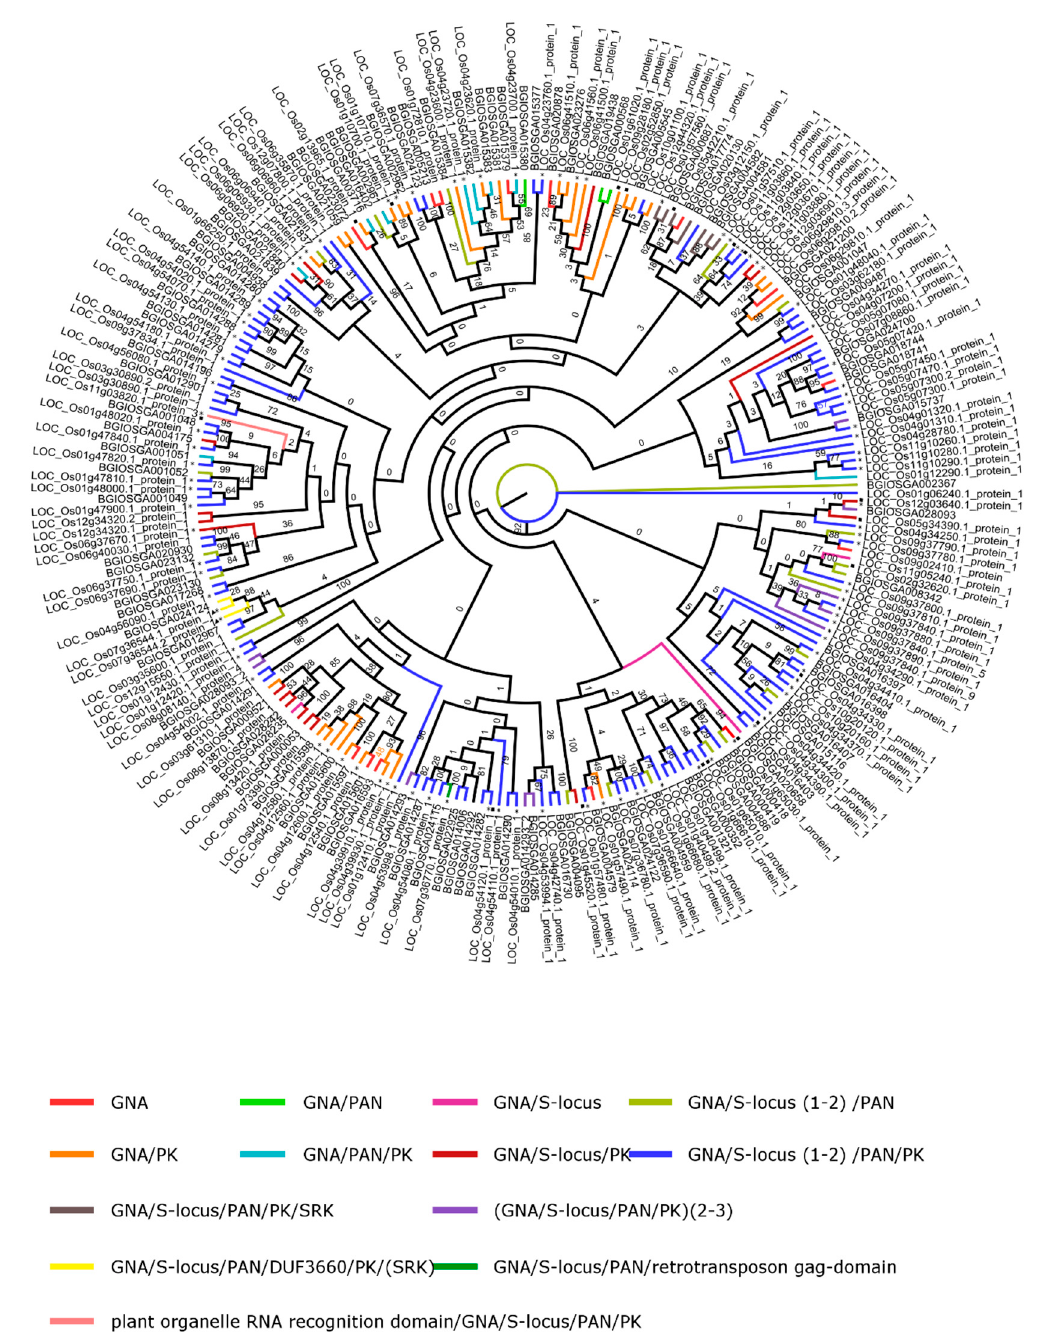
Figure 4. Phylogenetic tree of the GNA lectin family. Asterisks designate a tandem duplication event. Triangles refer to a single lectin domain in a multiple domain structure. Squares designate a segmental duplication event. The black numbers indicate the bootstrap values while the grey ones indicate the number of the clades. The numbers separated with underscore from the ID of the genes are referring to the number of the lectin domain in sequences that contain multiple lectin domains.